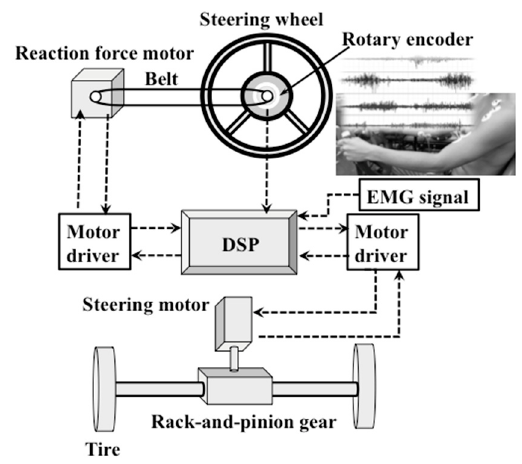
Figure 2. Steering assist system. Table 1. Steering motor and reaction force motor specifications.